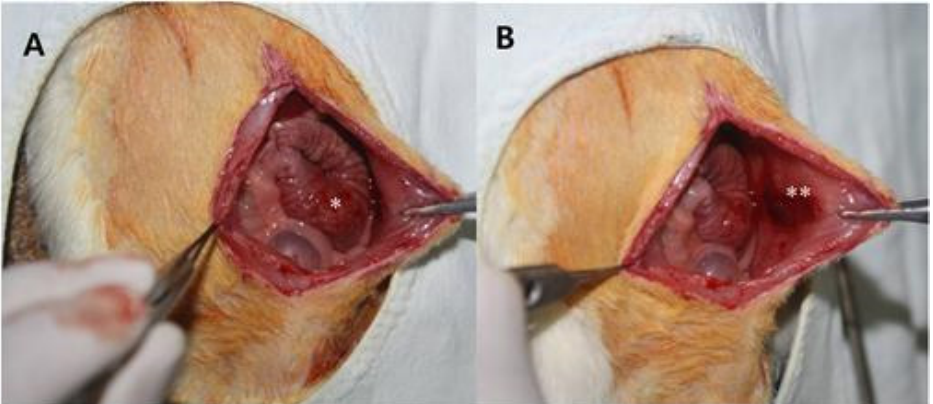
Figure 1. Photograph of the surgical technique. ( A ) The cecum was abraded with abrasive paper until an area of 100 mm 2 was deserosalized, as evidenced by punctate bleeding. ( B ) The abdominal wall was incised, and a 100 mm 2 defect was created by removing the peritoneum, including some muscle fibers. Note: * highlights the abraded cecum, and ** highlights the damaged abdominal wall.